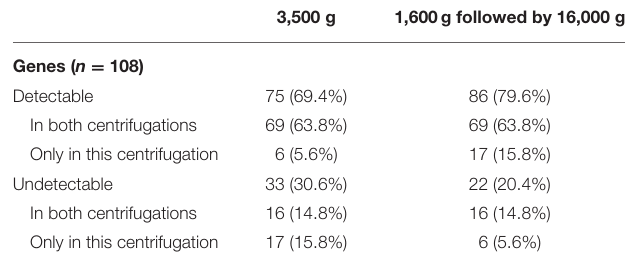
TABLE 1 | The summary of detection of genes in two centrifugal forces.